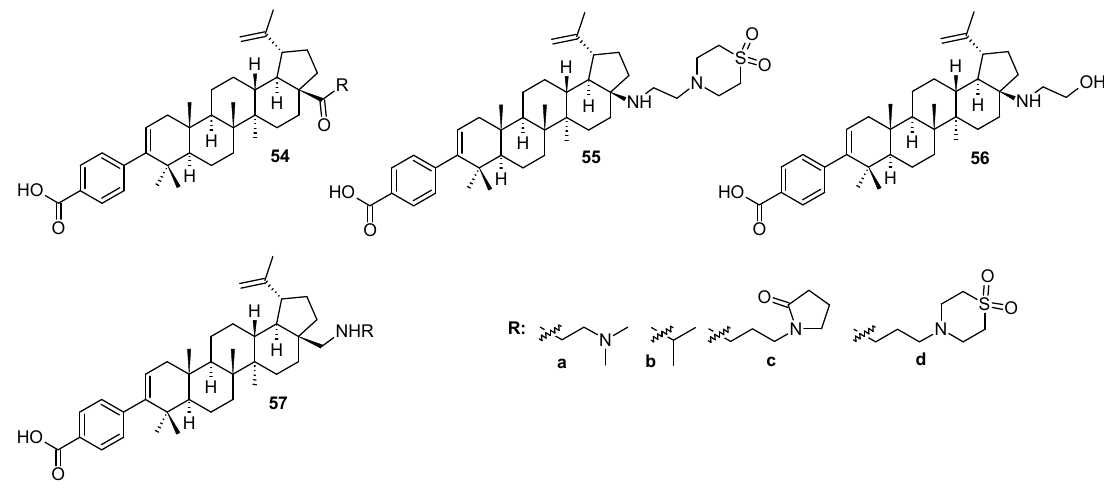
Figure 2. Structures of the HIV-1 maturation inhibitors based on betulinic acid ( 1 ).